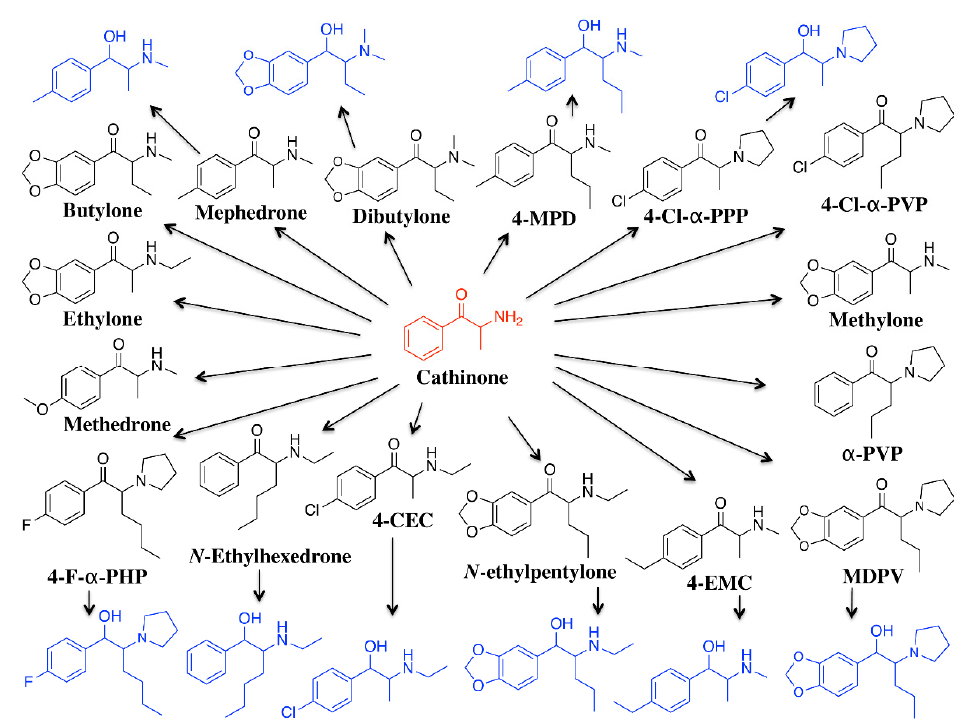
Figure 1. Chemical structure of synthetic cathinones (black) and reduced metabolites (blue) included in this study.